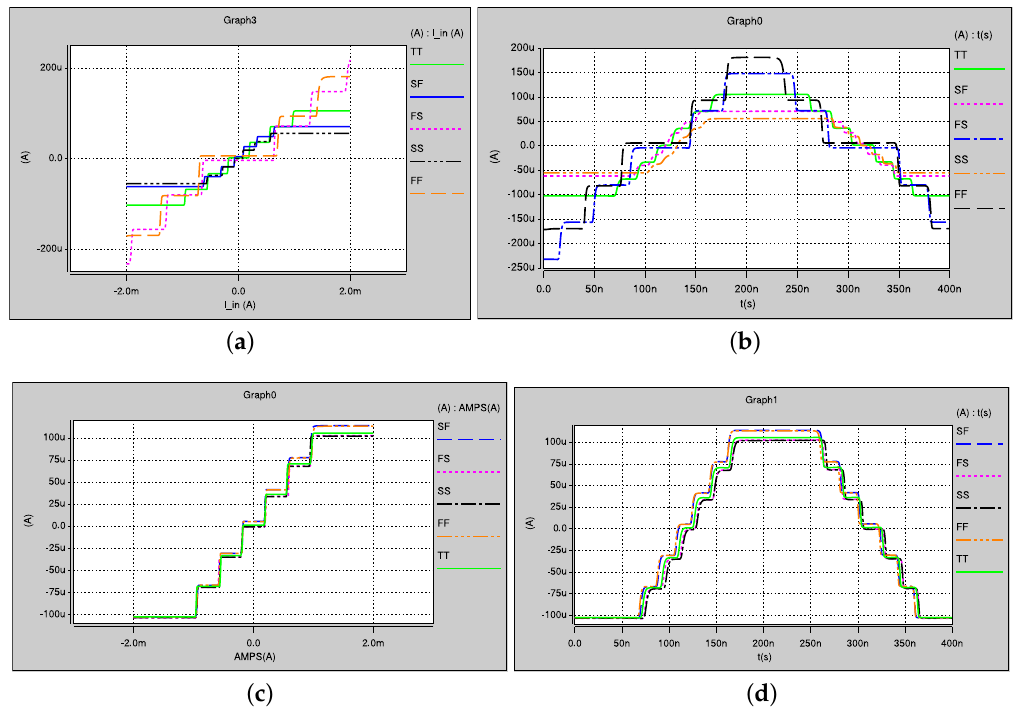
Figure 13. PVT simulation of the proposed PWL function to generate seven-scroll: ( a , b ) without adjustment of the current offsets; and ( c , d ) with adjustment of the current